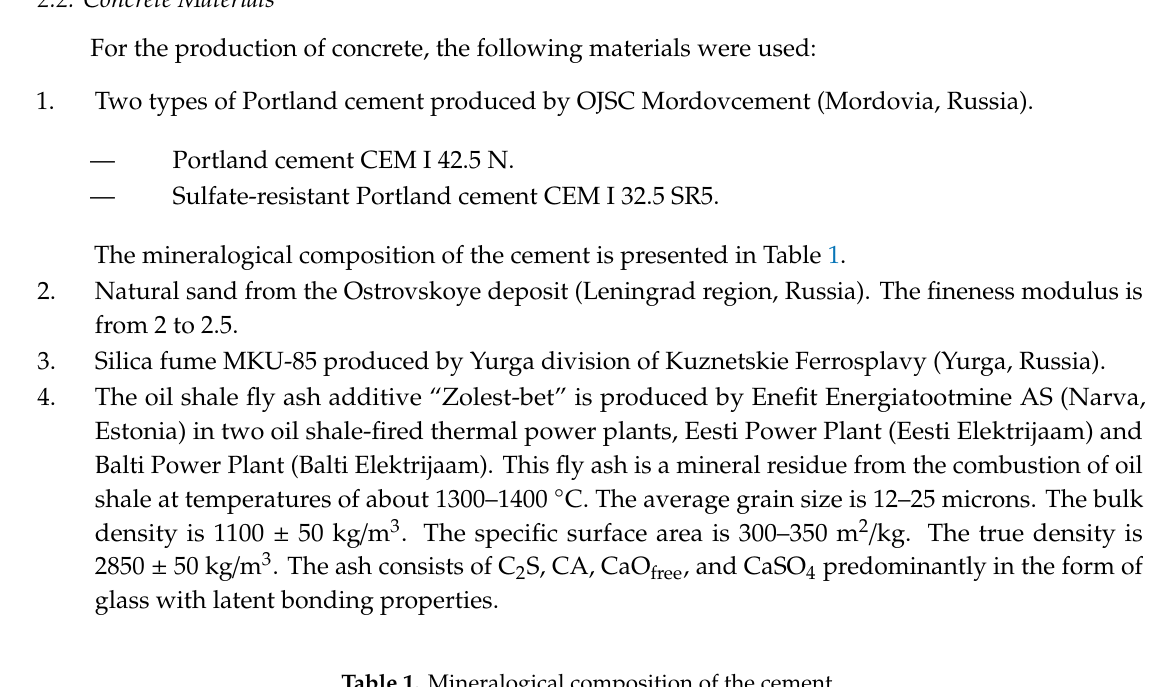
Table 1. Mineralogical composition of the